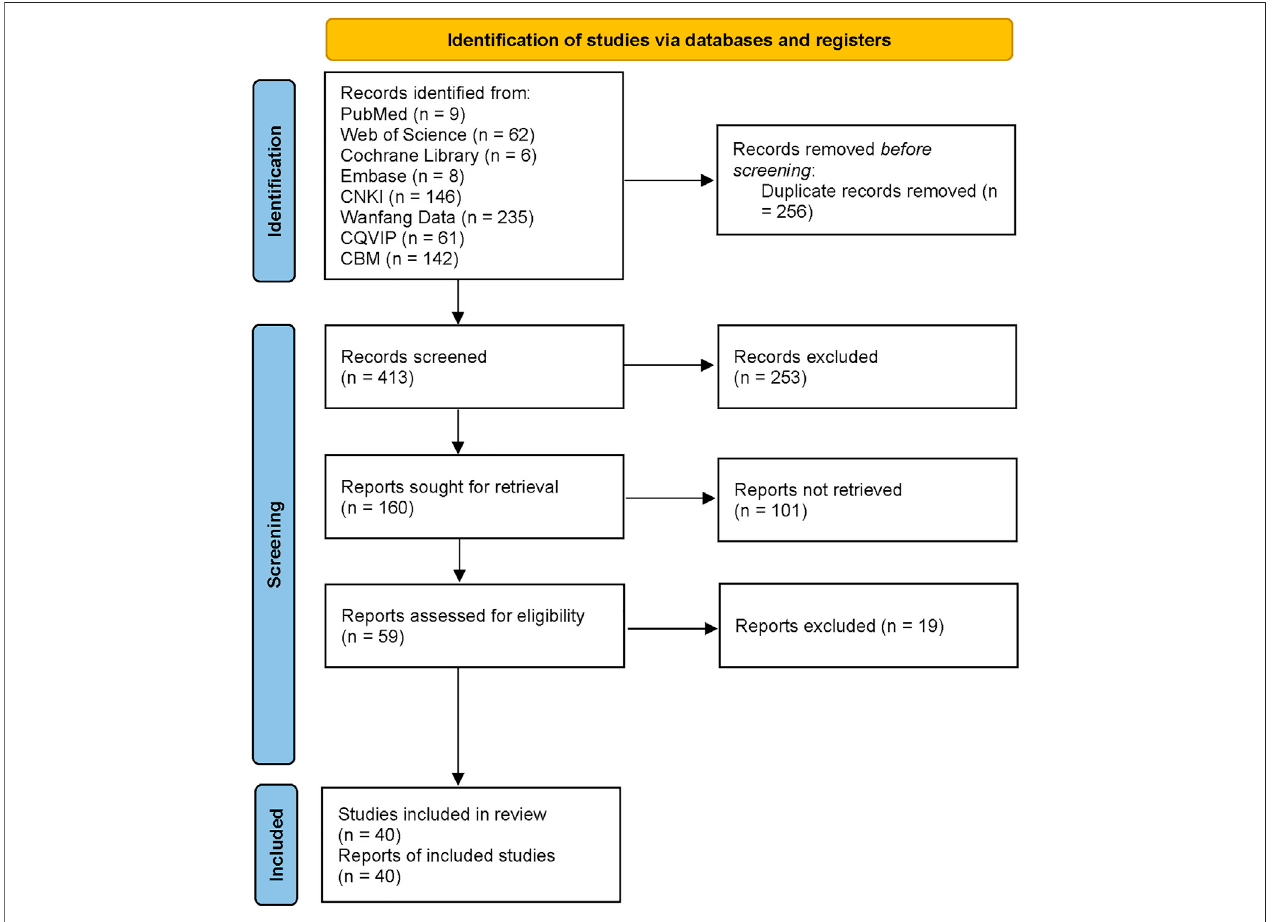
FIGURE 1 | Flow diagraph of study